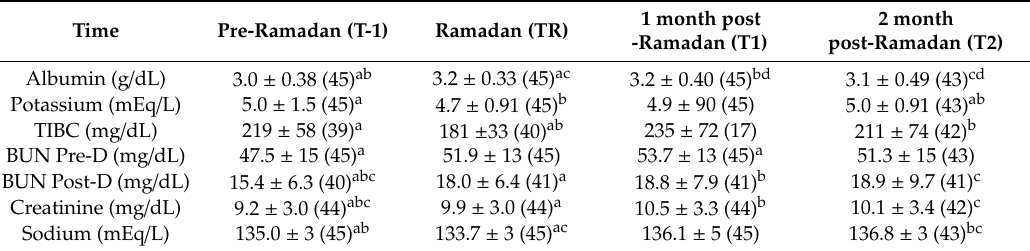
Table 2. Biochemical